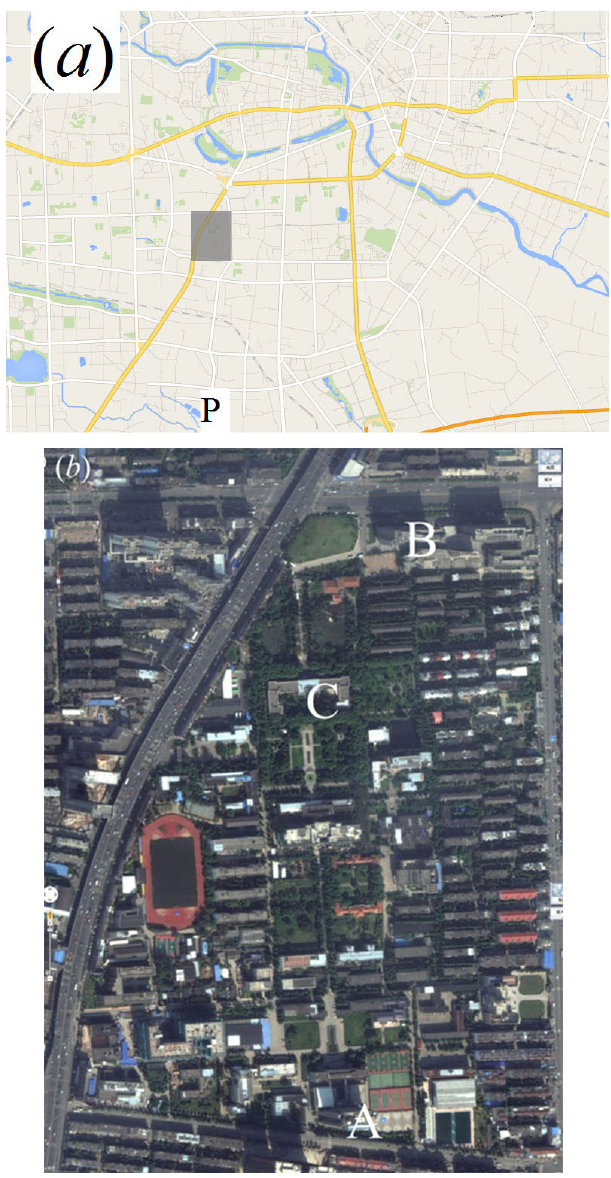
Figure 3. Photographs of the measurement site. (a) Map of the city of Hefei and (b) expanded view of the measurement site on the USTC campus, which is marked with the rectangle in (a) . Point P in (a) indicates the site from which visibility measurements were obtained. Points A and B in (b) show the locations of the transmitter and receiver, respectively. Point C in (b) marks the meteorological tower position. There are four heavy-traffic roads surrounding the measurement site. Figures 3a and b ©